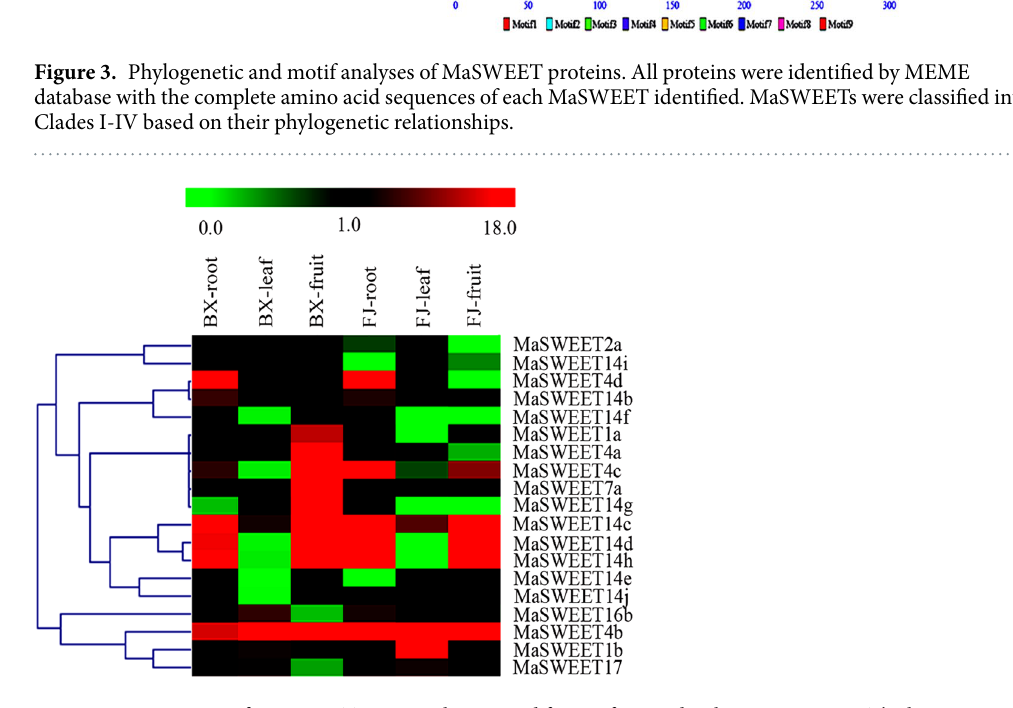
Figure 4. Expression of MaSWEETs in roots, leaves, and fruits of BX and FJ banana varieties. The heat map with clustering was created based on the FPKM value of the MaSWEETs . Differences in gene expression changes are shown in color as the